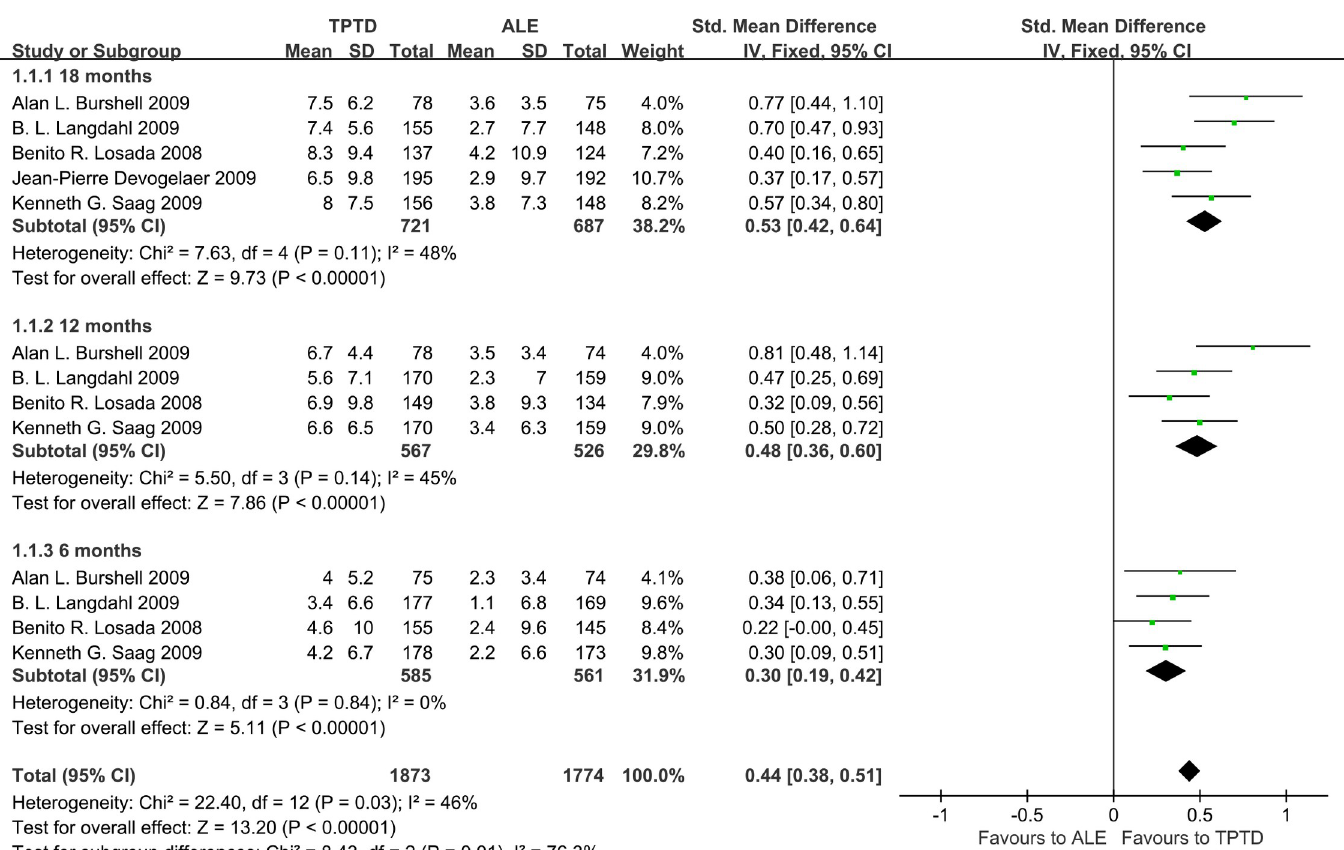
Fig 6. Forest plots of mean percent change from baseline to 6, 12, and 18 months in the LS BMD.